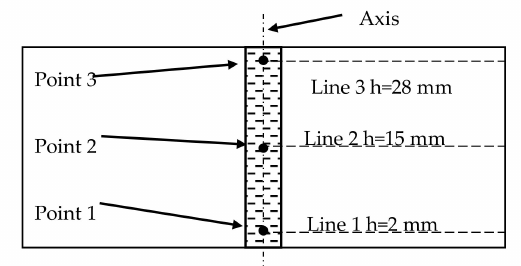
Figure 6. Monitor positions during the melting